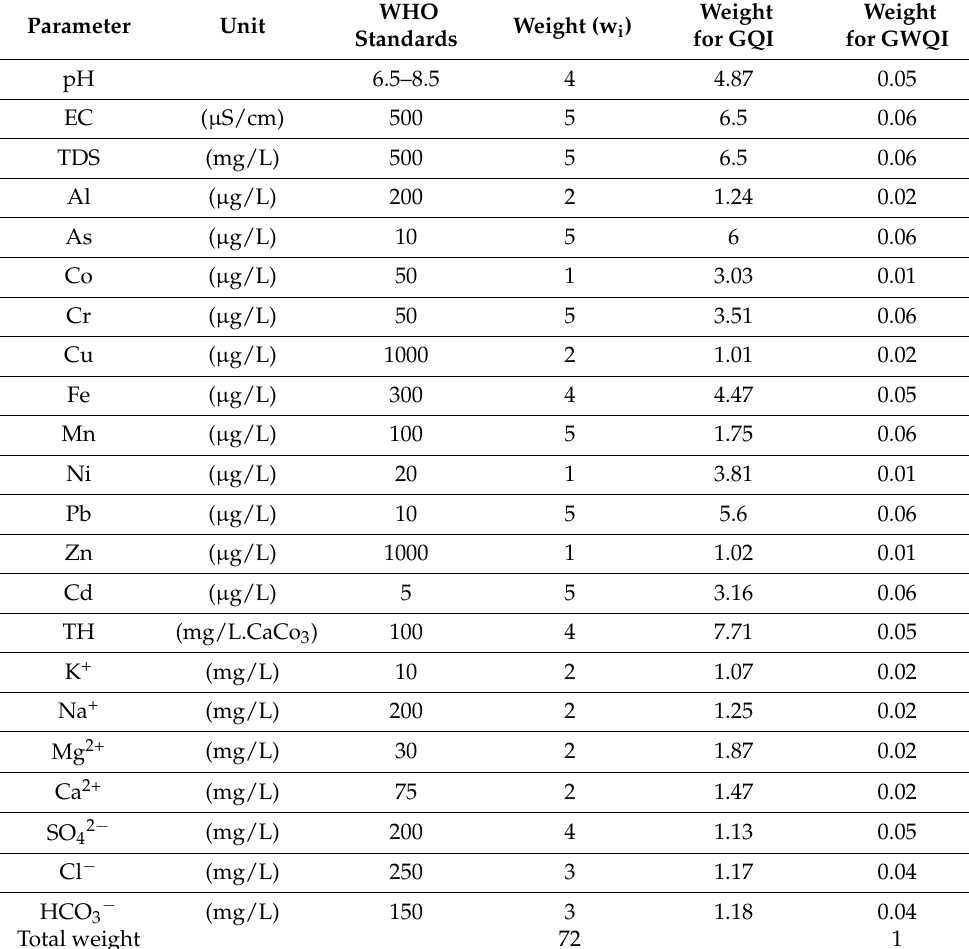
Table 3. Relative weight of water physicochemical parameters for GQI and